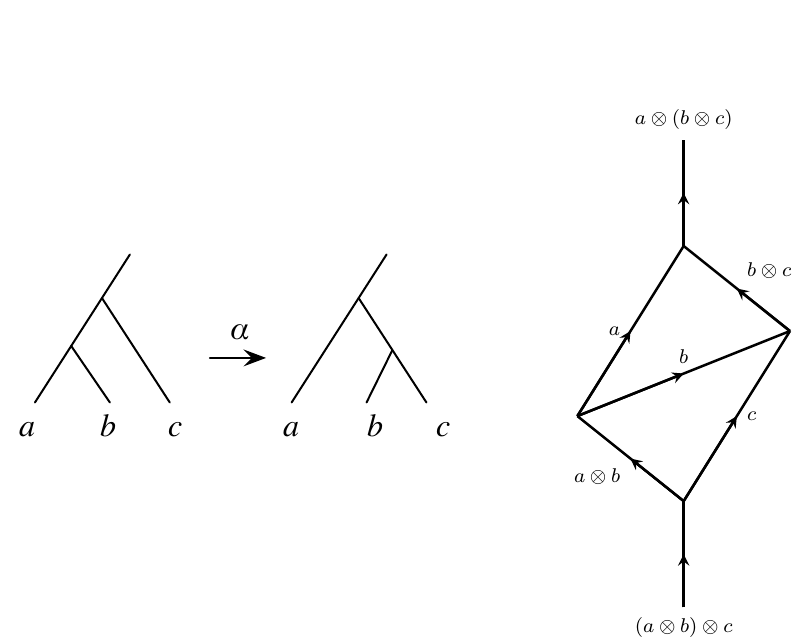
Figure 2 . Left: the associator relates two di(cid:11)erent orders to tensor three lines. Right: equivalently, the local operator labeled by the associator morphism is obtained by squeezing the region between ( a (cid:10) b ) (cid:10) c and a (cid:10) ( b (cid:10) c ) shown above to a point.